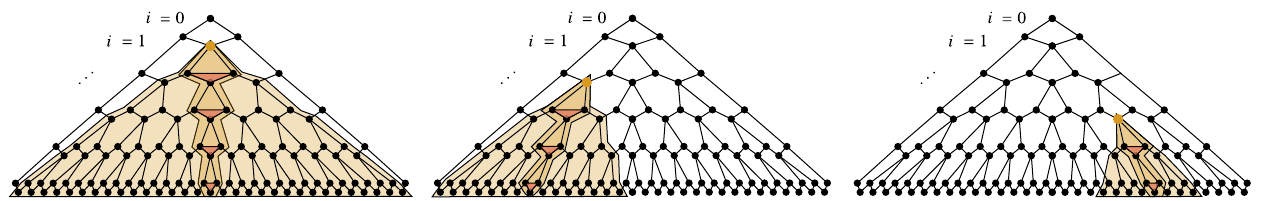
˜ L for the case when W is in the first sublayer or the l th layer of the QCNN. Here, B